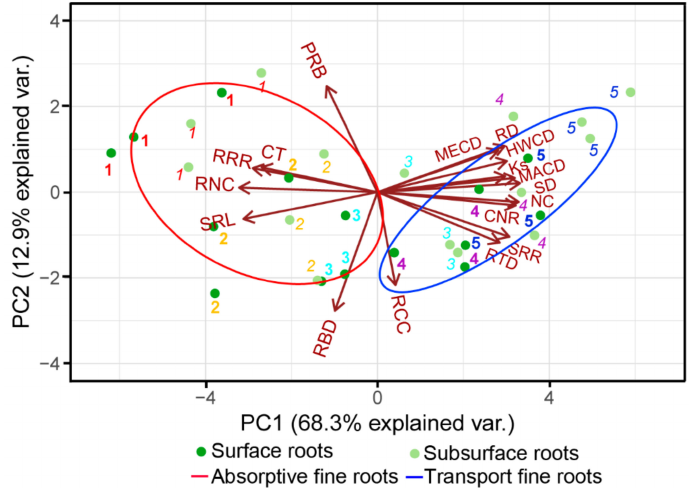
Figure 4. Principal component analysis (PCA) of the functional traits of the first five orders of roots in response to soil depth. The numbers in bold non-italics and in non-bold italics indicate the order of roots at surface (0–10 cm) and subsurface (20–30 cm) soil layers, respectively. The absorptive and transportive fine roots are classified based on their anatomical traits: when the abundance of absorptive roots was more than 50% in a given order (according to the Table 1), then roots in this order were defined as absorptive fine roots, otherwise they were transport fine ones. The trait abbreviations are as in Table